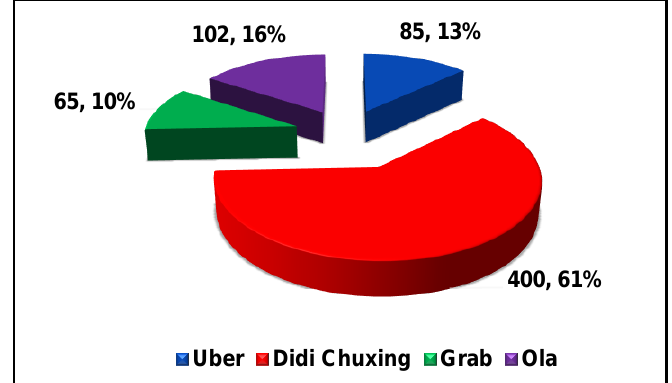
Fig. 2. Occupied regions by the globally renowned ride-sharing companies in Asia.